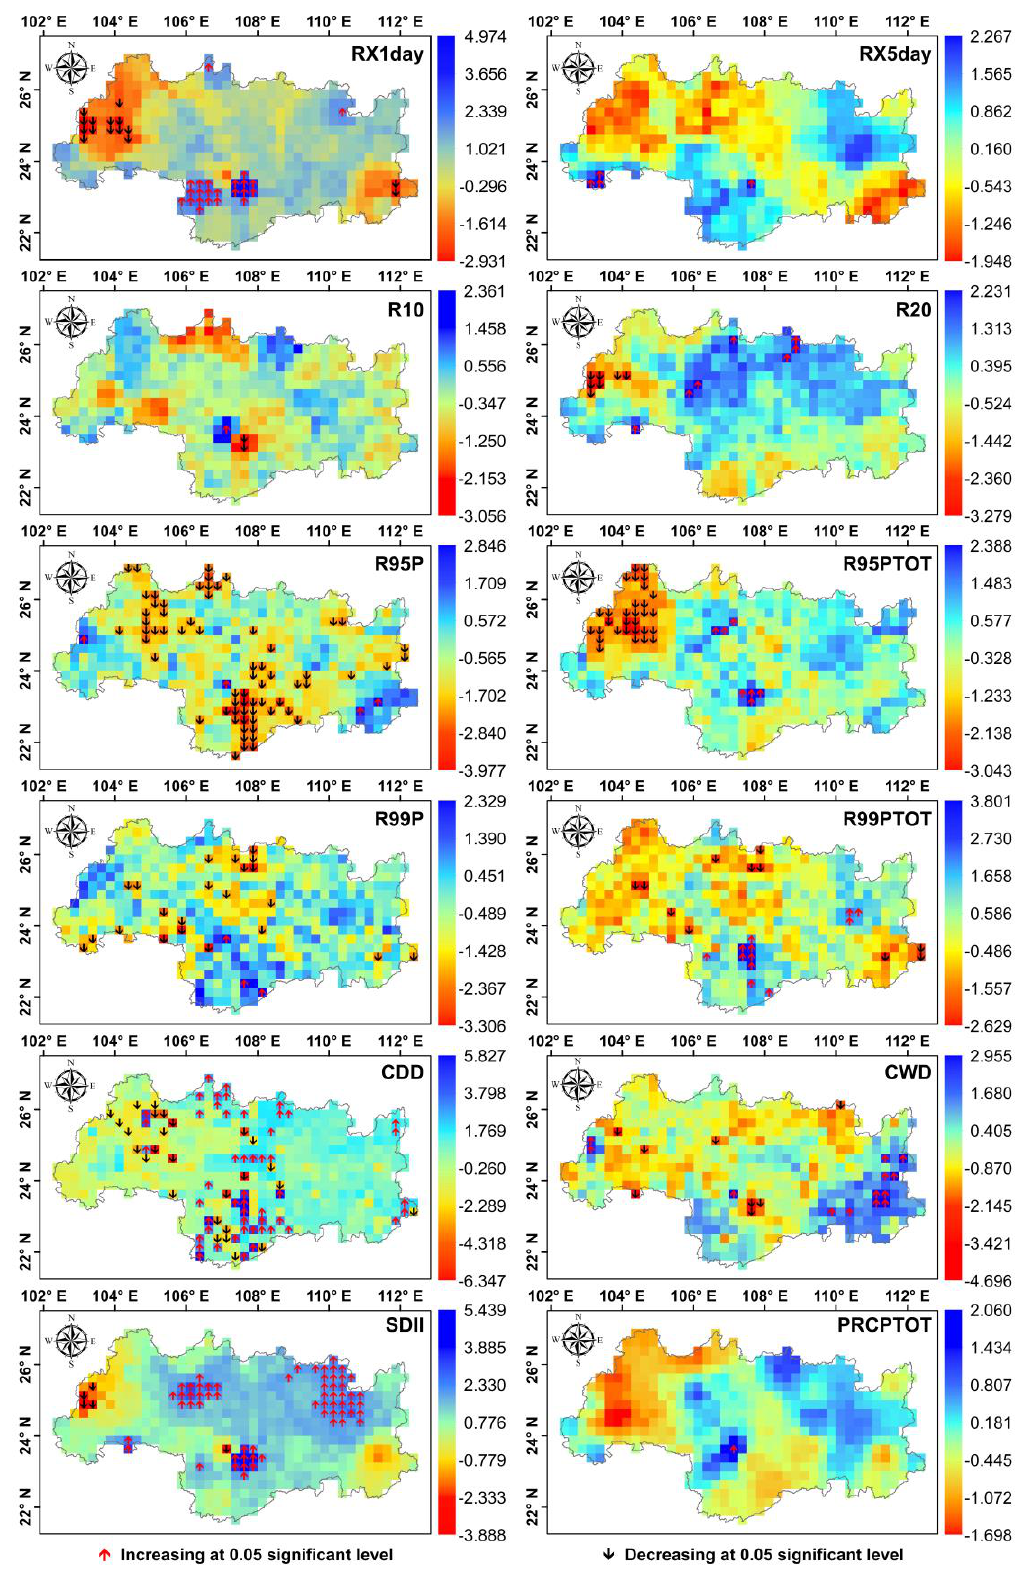
Figure 8. Spatial variability of trends for the extreme precipitation indices in the Xijiang River Basin between 1960 and 2008. At a 0.05 level, the upward red or downward black arrow indicates that this trend is increasing or decreasing significantly,